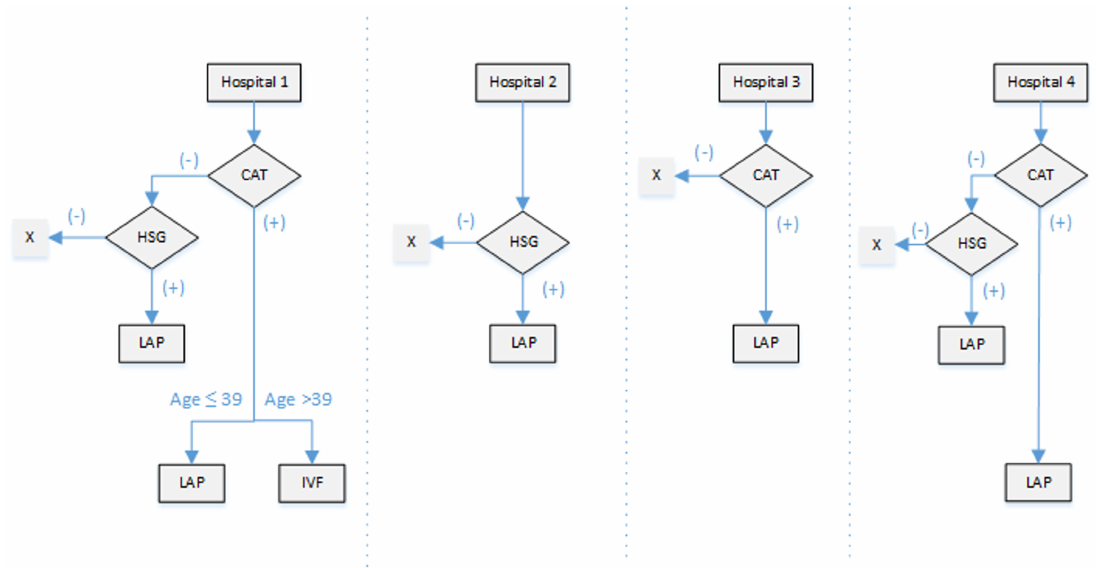
Figure 1. Overview of varying strategies in di ff erent fertility clinics across The Netherlands. In Hospital 1, tubal assessment begins with Chlamydia IgG antibody testing (CAT). Whenever CAT is negative (CAT-), hysterosalpingography (HSG) is done. In the case of abnormal HSG, the patient is referred for laparoscopy. In case CAT is positive (CAT + ), CAT + women undergo laparoscopy if younger than 39, whereas older women are directly referred for in vitro fertilization (IVF). In Hospital 2, CAT is not performed. HSG is done as the primary investigation of tubal patency, and laparoscopy is performed only in patients with abnormal HSG results. In Hospital 3, patients are first screened by CAT. In the case of CAT + , laparoscopy is performed. In the case of CAT-, no additional testing is done. HSG as a screening test is totally abandoned. In Hospital 4, screening starts with CAT. CAT + patients undergo laparoscopy regardless of their age, CAT- patients have HSG and, in the case of an abnormal HSG, they undergo laparoscopy. The symbol X stands for no referral for further